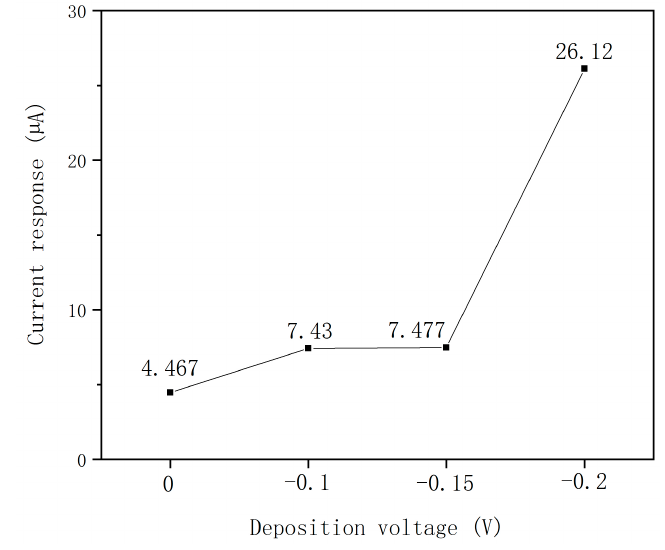
Figure 3. Current response of the Pd ‐ AuNPs modified with different deposition voltages.